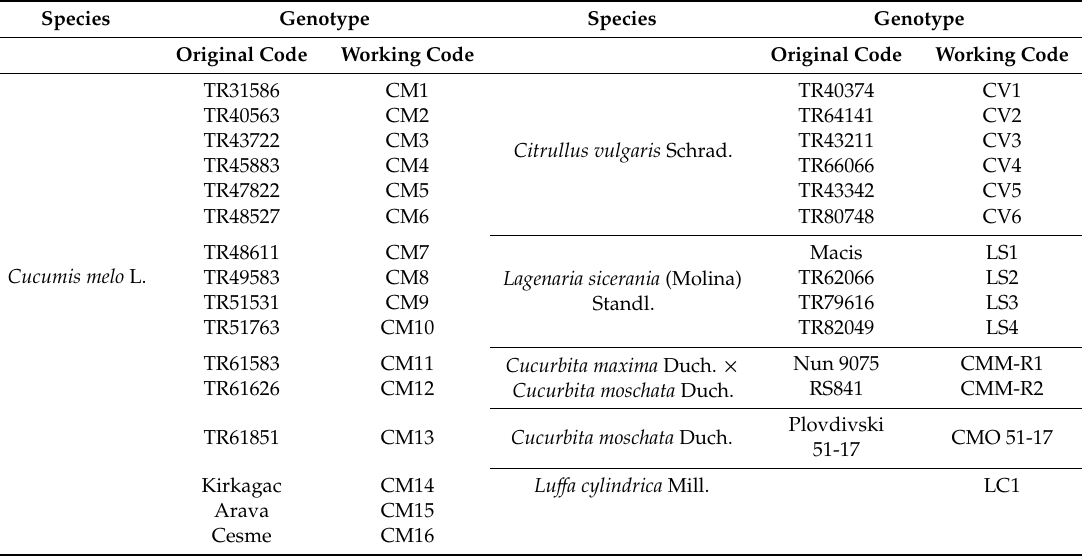
Table 1. List of the tested species and the relative genotypes used in this study. Species Genotype Species Genotype Original Code Working Code Original